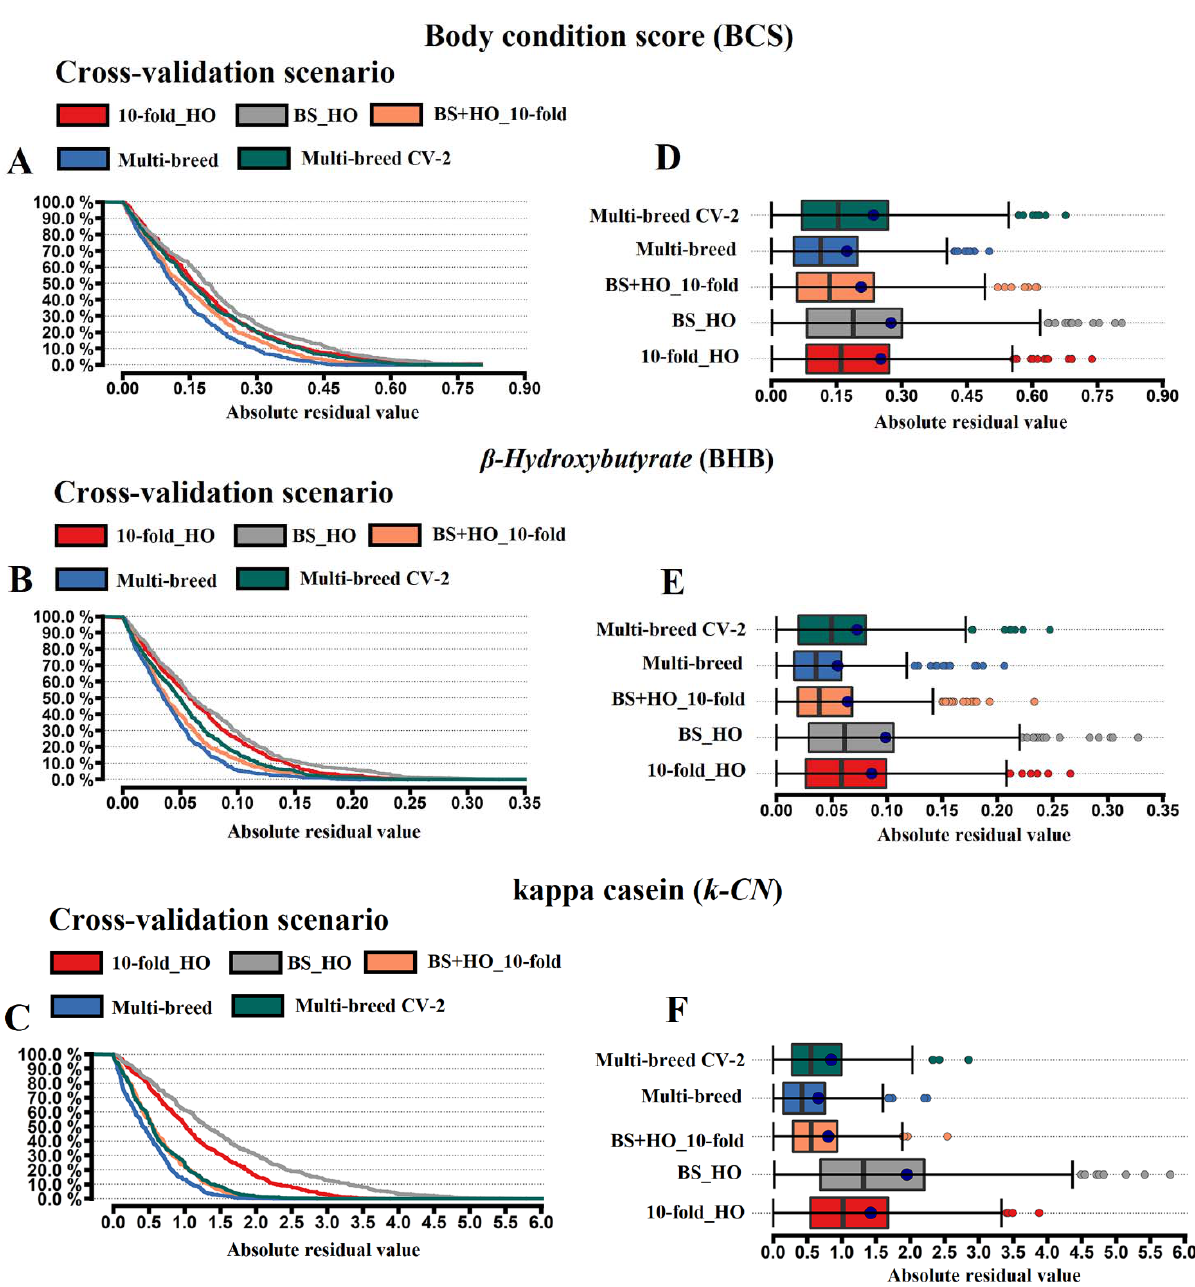
Figure 3. Residual diagnostics comparison across cross-validation designs for the FTIR prediction of body condition score (BCS), blood β -Hydroxybutyrate (BHB, mmol/L), and kappa casein (k-CN, % N). Absolute residual distribution (( A ) for BCS, ( B ) for BHB and ( C ) for k-CN) and box plot of the absolute errors (( D ) for BCS, ( E ) for BHB and ( F ) for k-CN) between the observed and predicted phenotypic values.